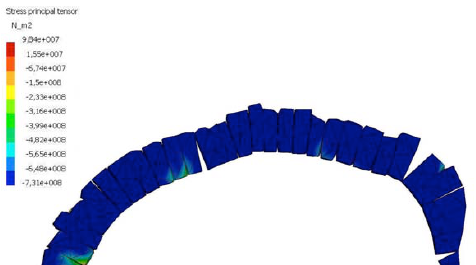
Figure 8. Distribution of stress and aperture of hinges during the formation of the mechanism of collapse of the arch under